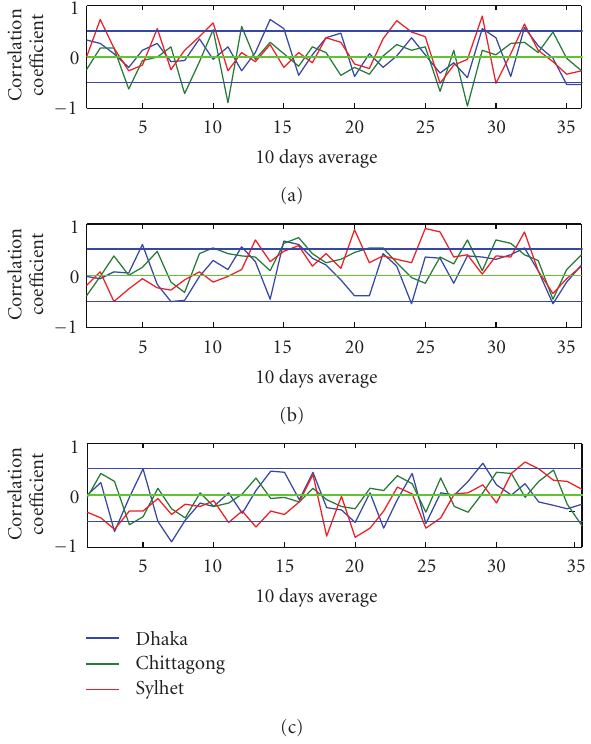
Figure 5: Correlations between DY and (a), average rainfall (b), mean temperature (c), and m ean